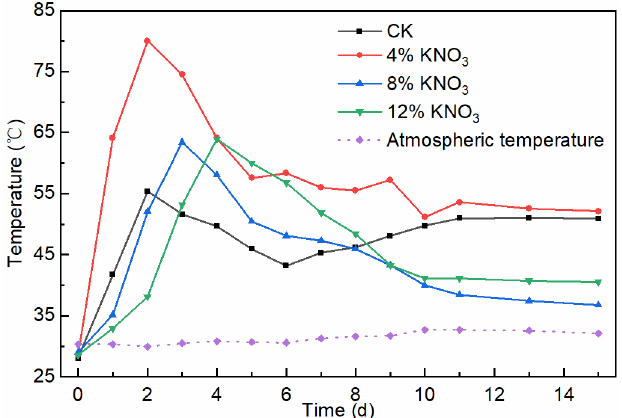
Figure 2. Changes in the composting pile temperature under different KNO 3 additions.